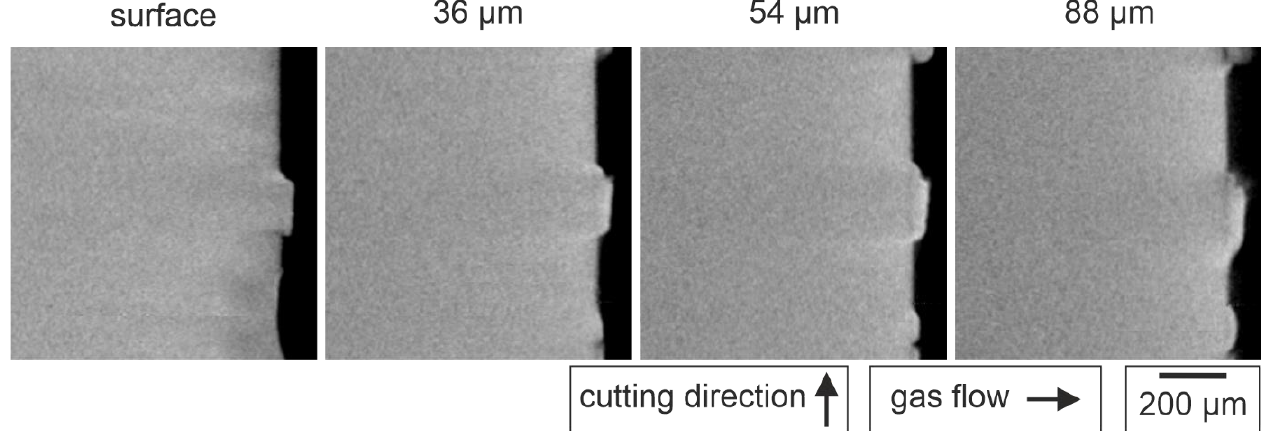
Figure 6. Selection of observation planes of the same re-solidified material droplet in the as-cut condition at different observation depths starting from the surface of the laser-cut edge.